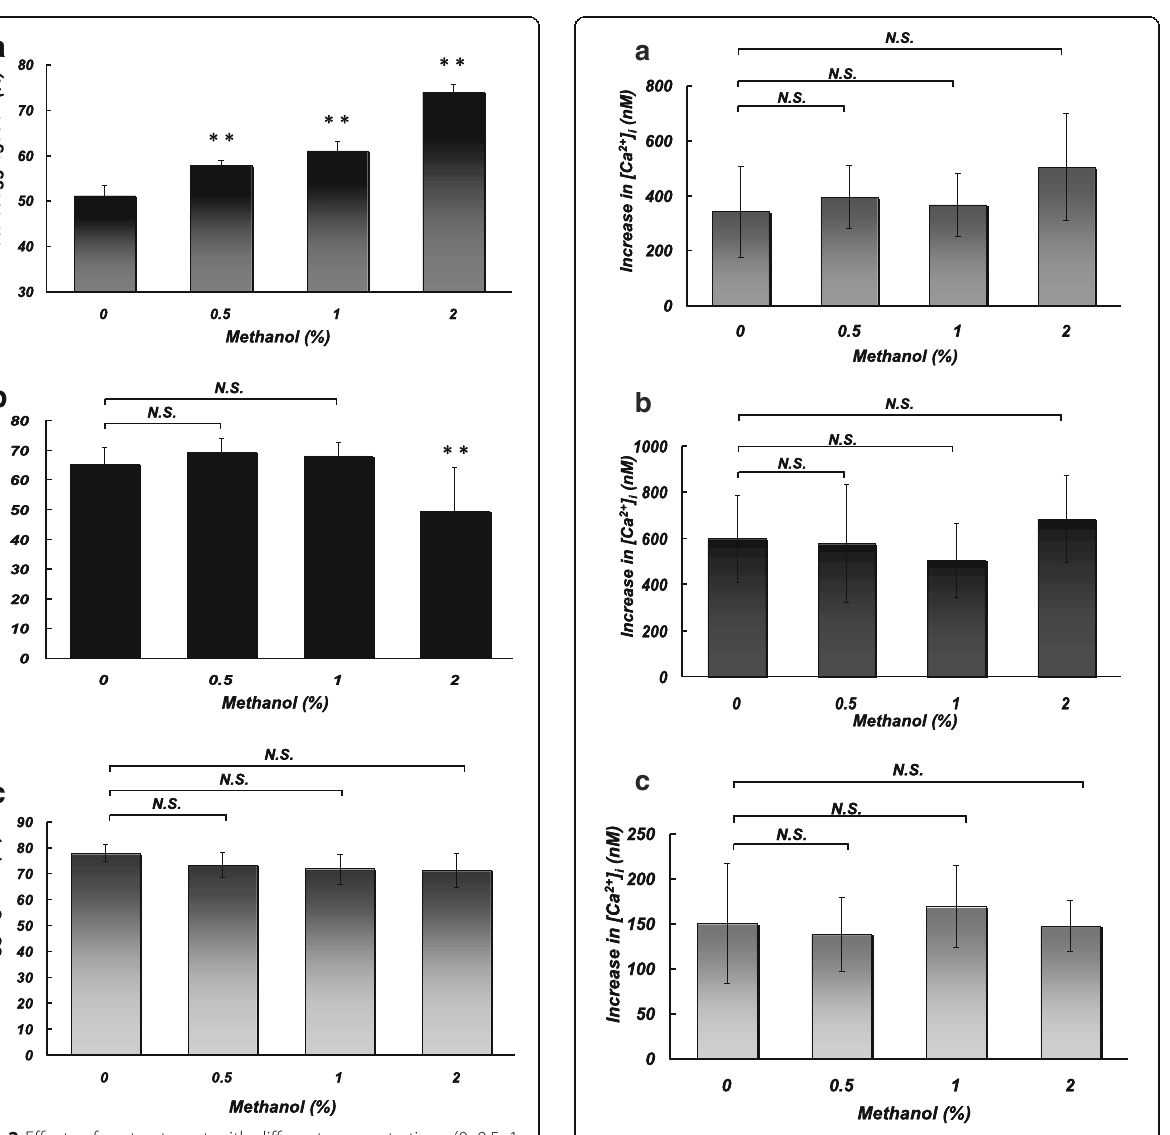
Additions of formic acid at 0.005, 0.01, and 0.02% to the solution suspending platelets lowered its pH (means ± standard deviations) from 7.424 ± 0.005 to 7.299 ± 0.043 ( p < 0.05), 7.017 ± 0.013 ( p < 0.01), and 6.234 ± 0.085 ( p < 0.01), respectively.